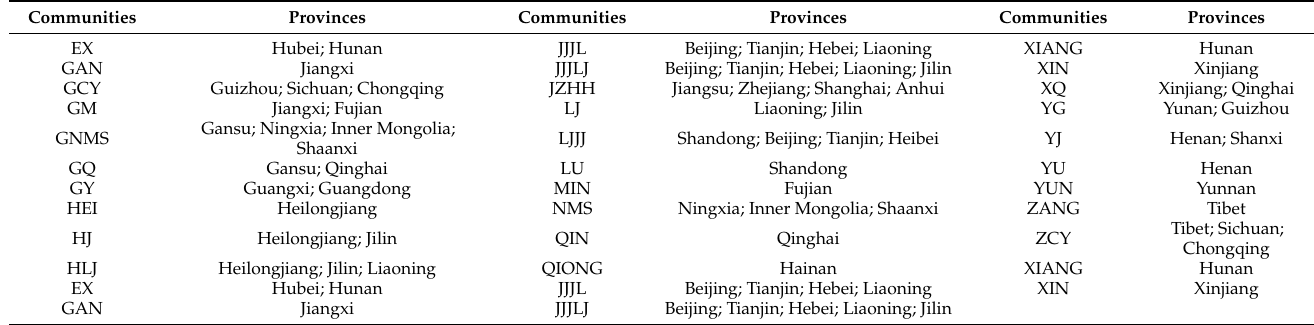
Table 3. The urban communities information table.